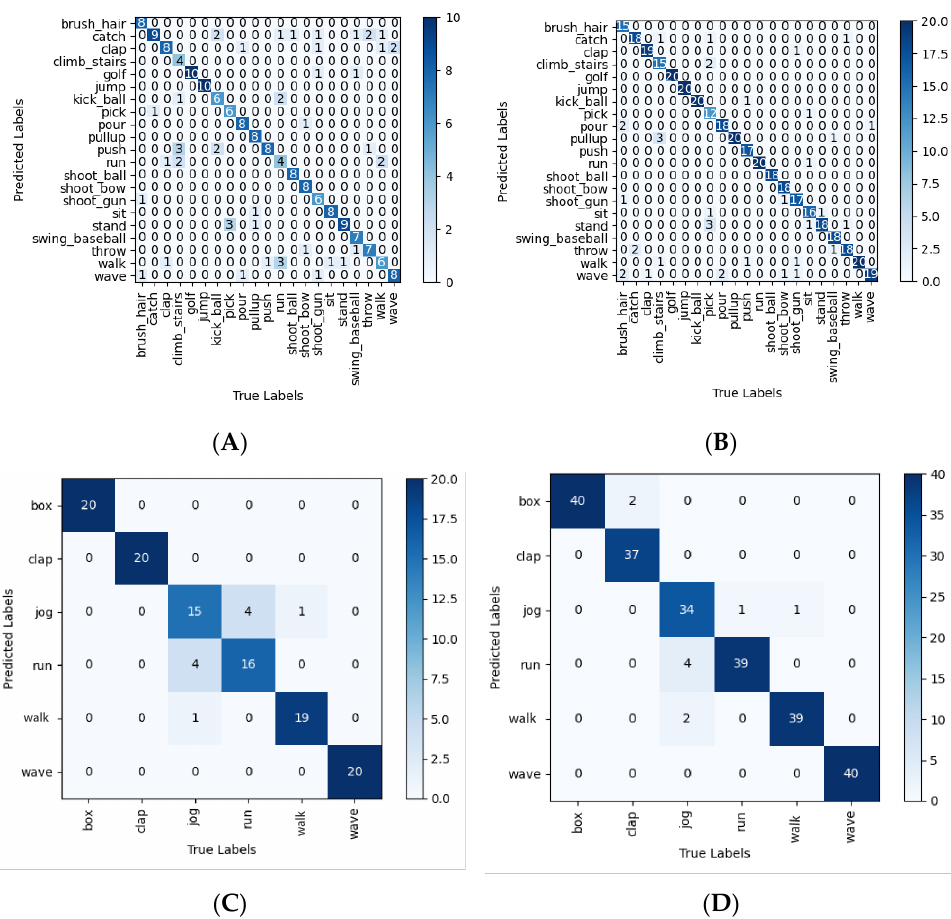
Figure 13. Confusion matrix of JHMDB and KTH dataset: ( A ) JHMDB; ( B ) enhanced JHMDB; ( C ) KTH; ( D ) enhanced KTH. Table 4. Comparison of indicators before and after flipping enhancement of the JHMDB dataset.